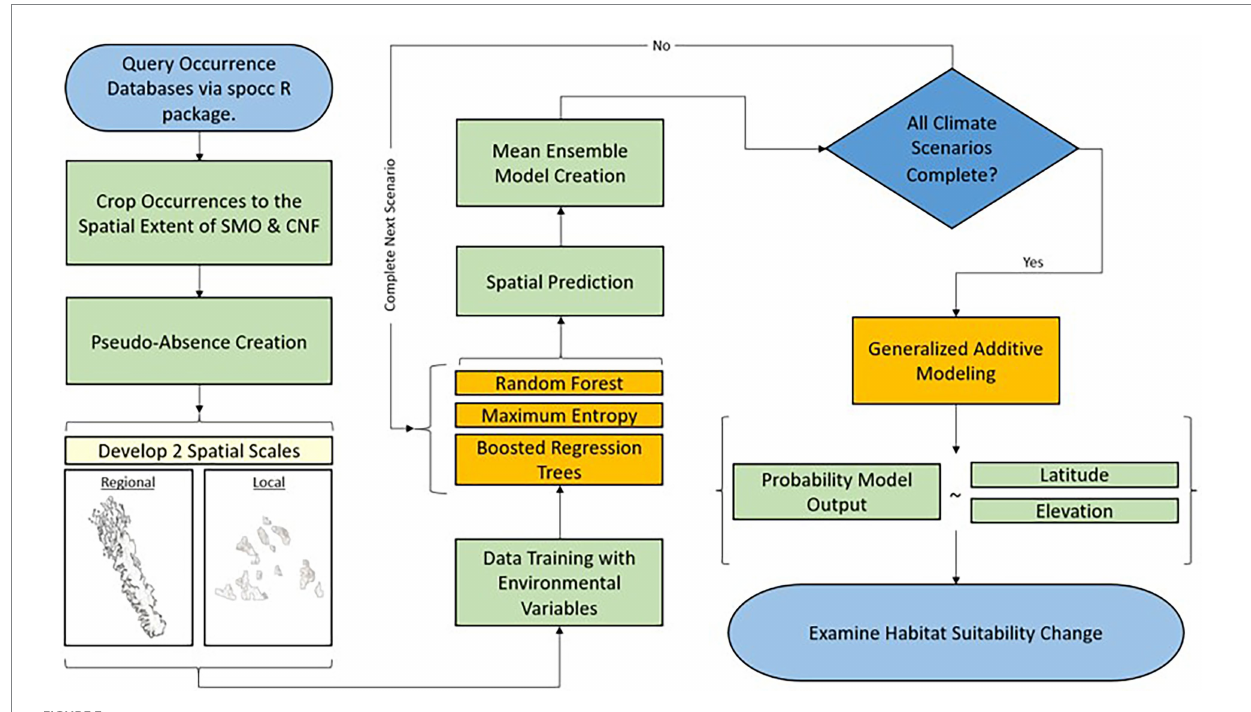
FIGURE 3 Methodology flow-chart.